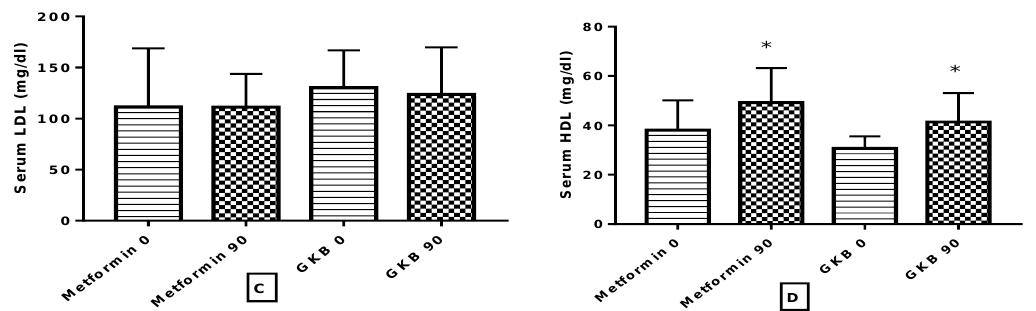
Figure 4. Effect of Gingko biloba extract (GKB) on the serum level of (A) Total cholesterol (B) Triglycerides (C) LDL and (D) HDL of patients with metabolic syndrome. Values were presented as mean ± S.D; * significantly different compared with baseline values (paired t -test, P <0.05).